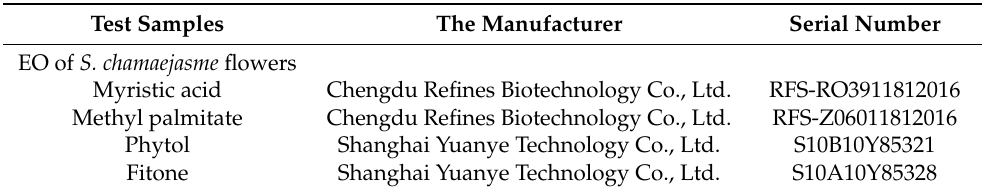
Table 6. Test samples for